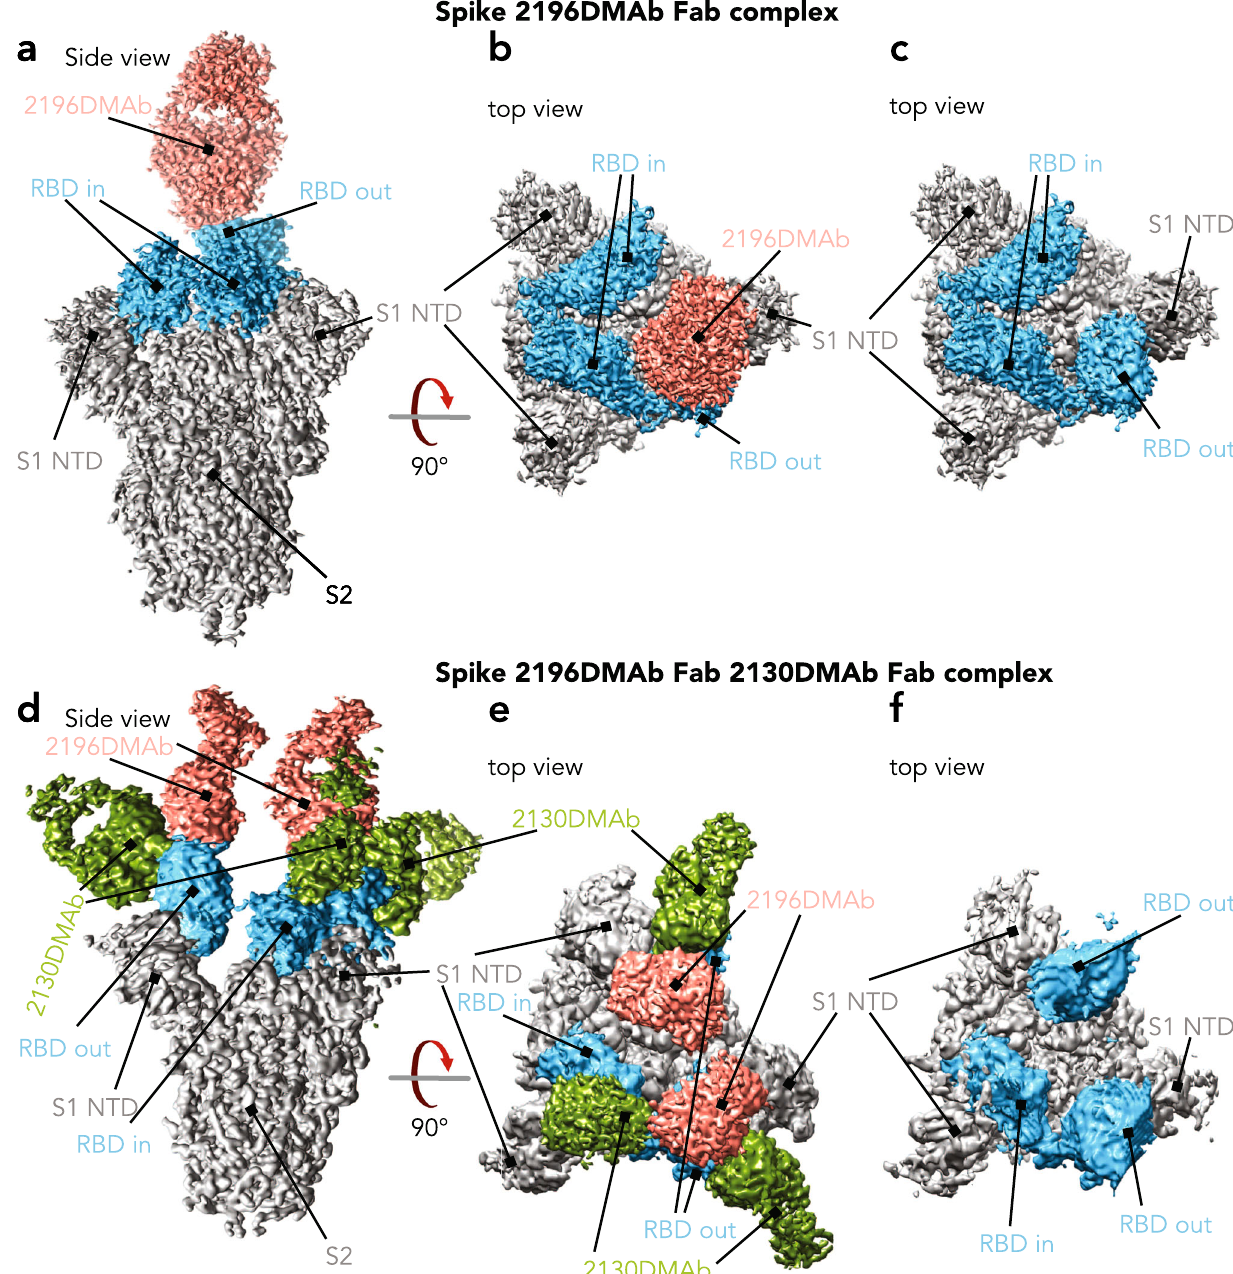
Fig.6|Cryo-EMinvivo - produceddFabscomplexedwithstabilizedSARS-CoV-2 (WA1/2020) spike trimer. a – c Cryo-EM density map of 2196 dFab (salmon) com- plexed to SARS-CoV-2 spike trimer (gray) with RBD indicated (blue). a Side view. b Top view. c Top view with dFab density removed. d – f Cryo-EM density map of